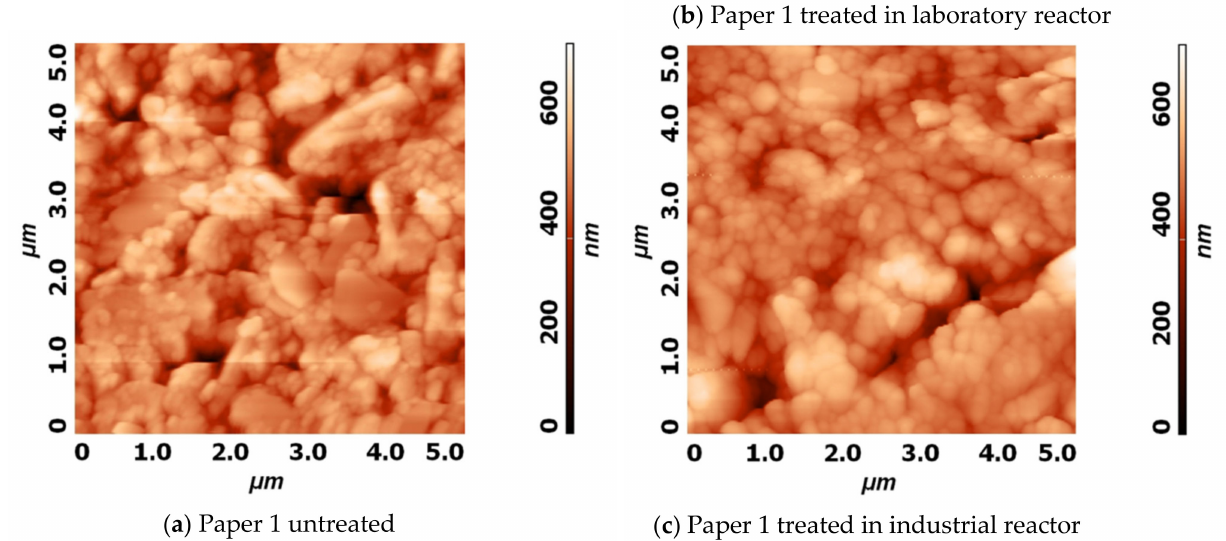
Figure 3. AFM images of height profiles on paper 1 before ( a ) and after plasma treatment in laboratory ( b ) and industrial ( c )